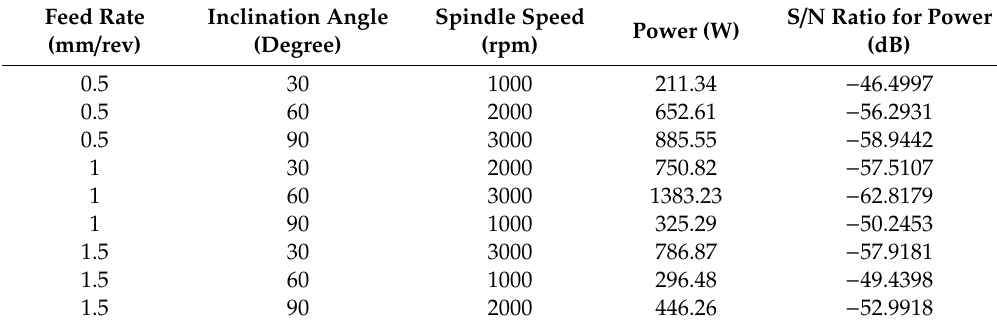
Table 8. The measured cutting power responses and the corresponding signal to noise ratios.